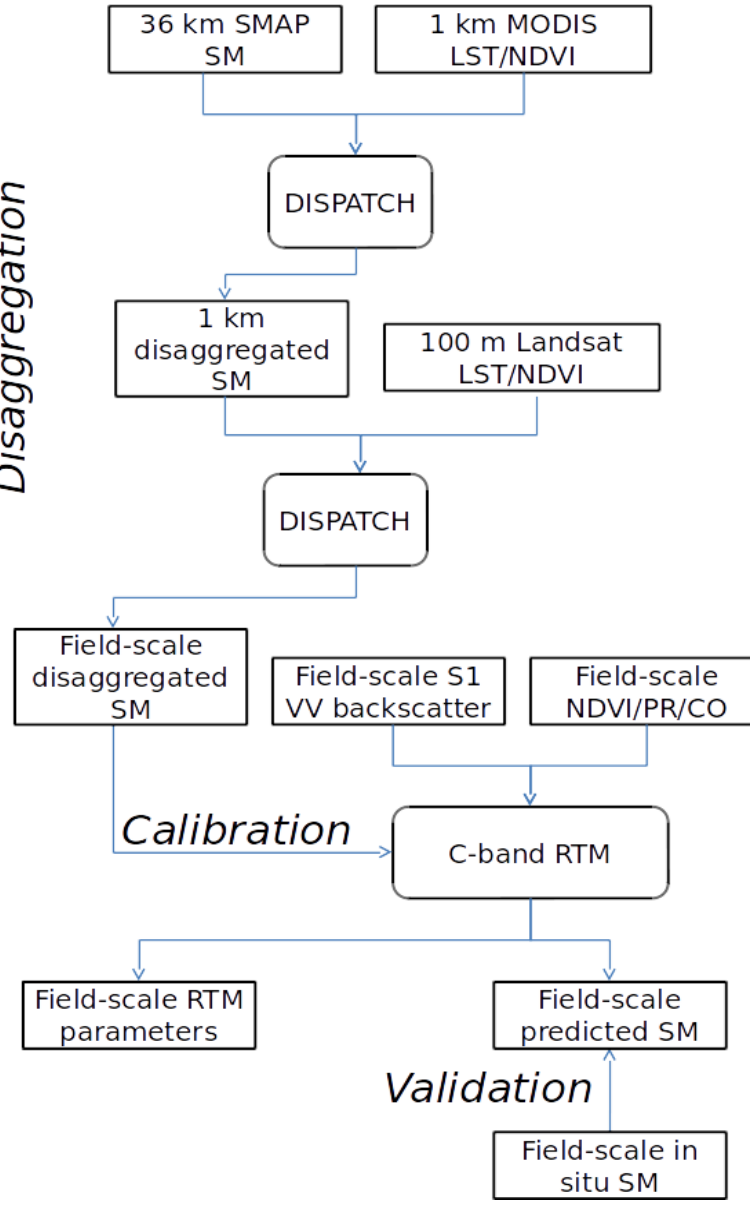
Figure 2. Schematic diagram of the calibration/disaggregation coupling scheme combining SMAP passive microwave, MODIS/Landsat optical/thermal and Sentinel-1 radar data at a range of spatial resolutions to provide an SM product at the field scale at the temporal frequency of